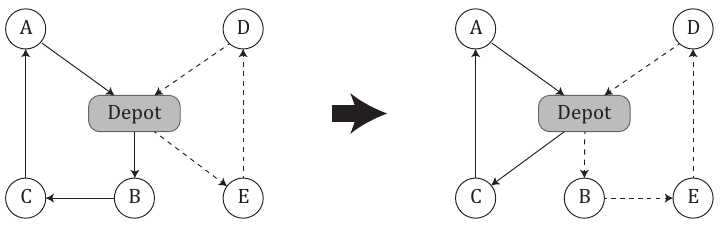
Figure 2. Example of 1-move of B from solid line route to dashed line route.